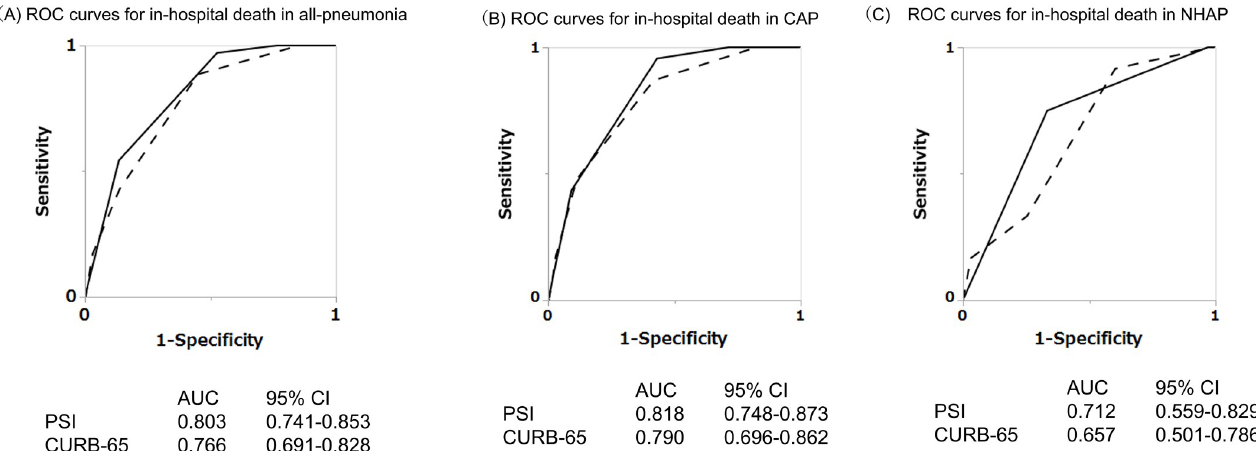
Fig 1. ROC curves of PSI or CURB-65 for predicting in-hospital death in all-pneumonia, CAP, and NHAP cases. Solid lines represent the ROC curves of PSI classes. Dashed lines represent the ROC curves of CURB-65 scores. The AUCs are shown at the bottom of each figure. The AUCs of both PSI and CURB-65 are sufficient to predict the in-hospital deaths in